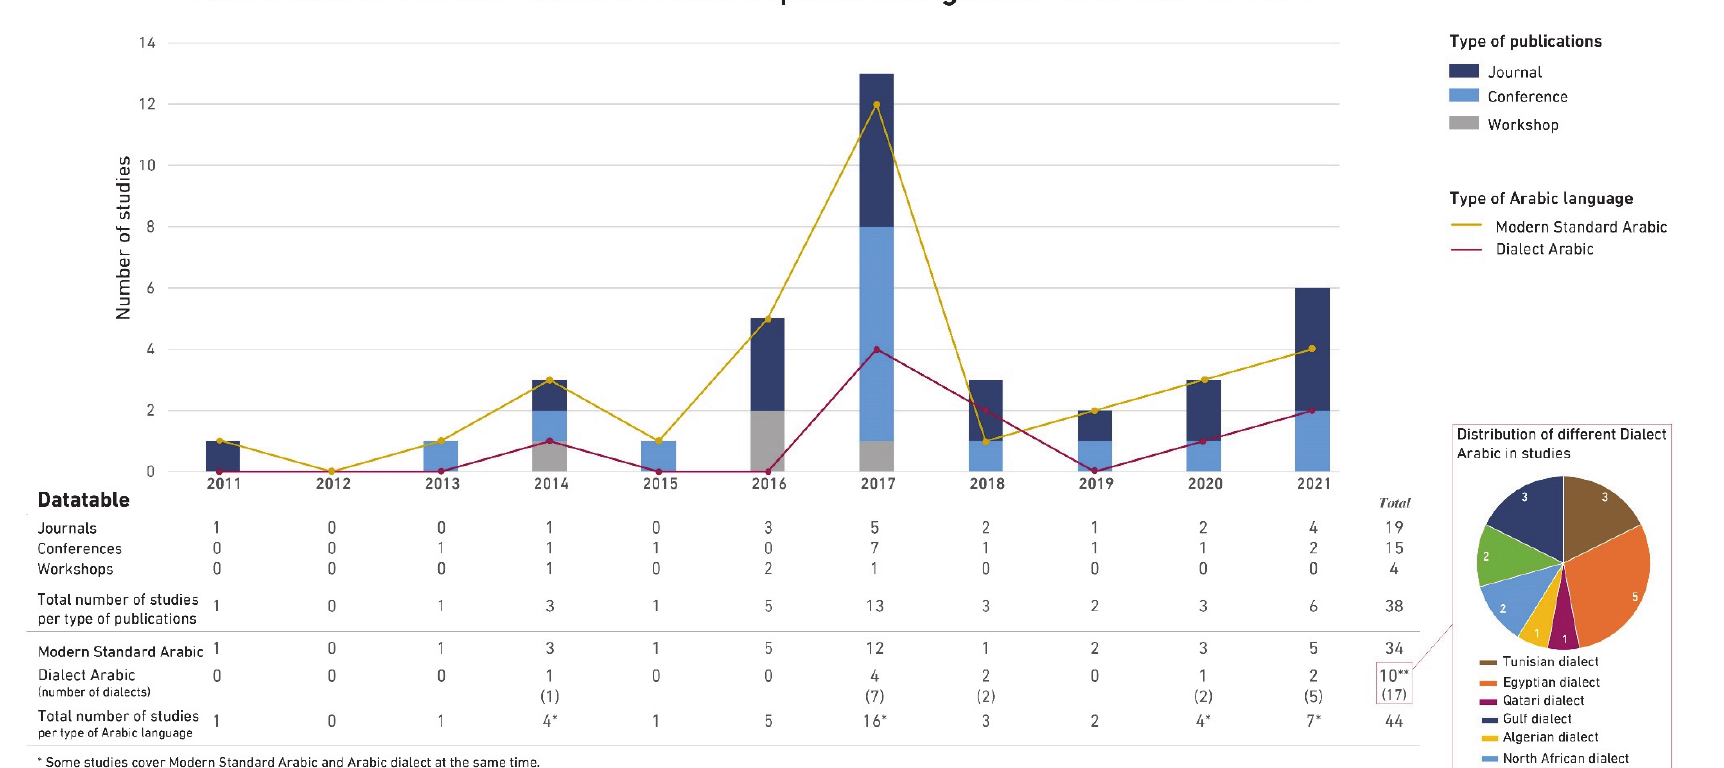
Figure 3. Distribution of Arabic speech recognition studies per publication years, types, and variants of Arabic language and dialects. Some studies support more than one variant of Arabic and can focus on multi-dialects of Arabic. Accordingly, the same study has been repeated, which increases the total number of studies per type of Arabic language.